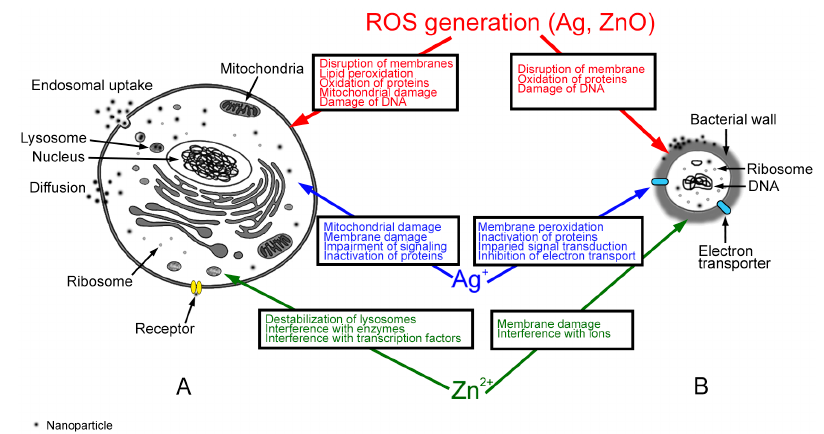
Figure 2. Effects of Ag and ZnO NPs in eukaryotic ( A ) versus prokaryotic ( B ) cells with mechanisms (ROS generation, action of Ag and Zn ions) indicated by different colors. NPs may enter mammalian cells either by endosomal uptake or by diffusion. For bacterial cells, the only uptake mechanism is diffusion across the bacterial wall. Target organelles for NP effects, such as mitochondria, lysosomes and nucleus, are indicated. Ribosomes are essential components of mammalian and bacterial cells; they are in a similar size range as NPs. ROS, reactive oxygen species.